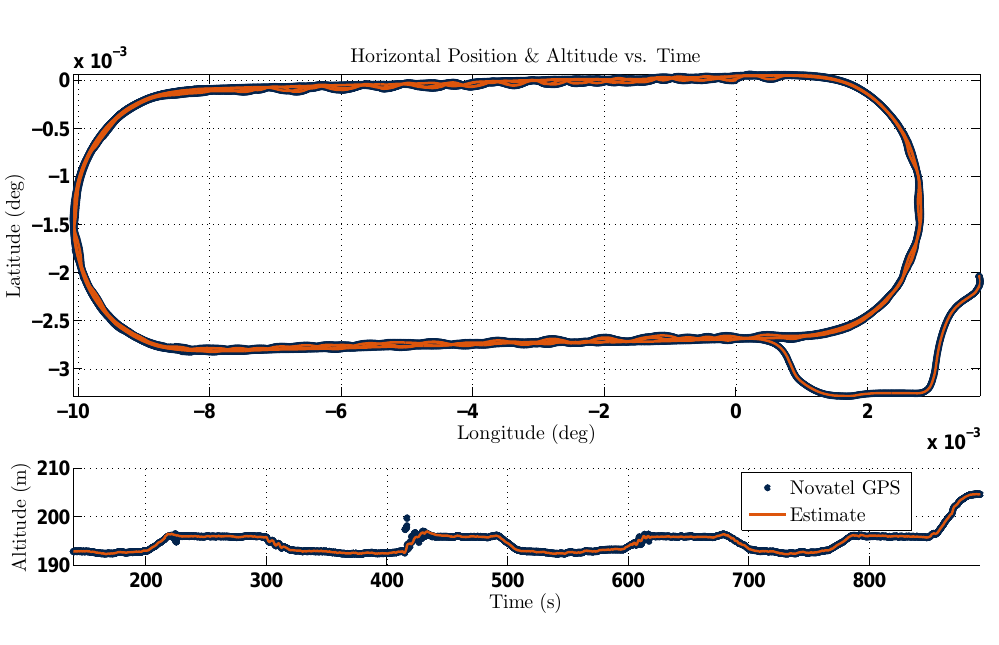
Figure 8. Position on the NCAT oval track 15-state cascaded